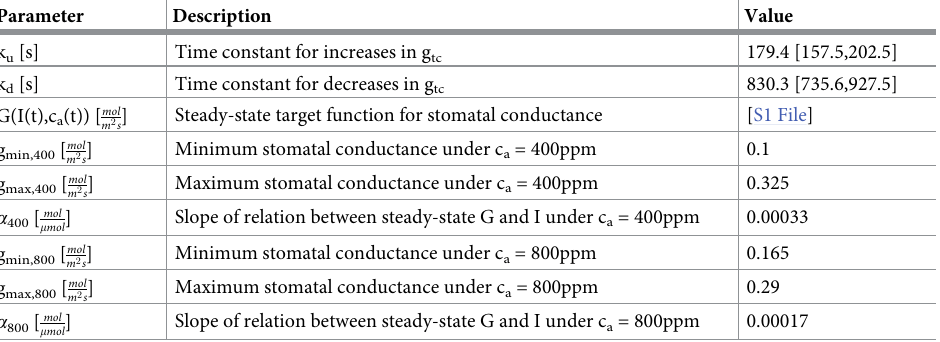
Table 2. Values of the model parameters in expressions 15 and 16. Parameters of the steady-state target function G(I (t),c a (t)), computed under c a = 400ppm and c a = 800ppm, respectively, are also included. Estimated unknown system parameters are given with accompanying confidence intervals.